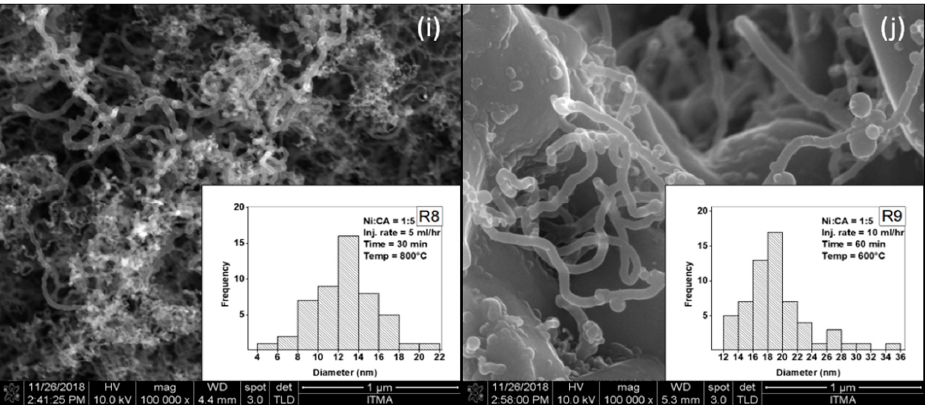
Figure 3. ( a ) Field emission scanning electron microscopy (FESEM) image of bare cordierite monolith; FESEM image and size distribution of CNTs monolith for ( b ) run 1; ( c ) run 2; ( d ) run 3; ( e ) run 4; ( f ) run 5; ( g ) run 6; ( h ) run 7; ( i ) run 8; and ( j ) run 9 of Taguchi-based design.